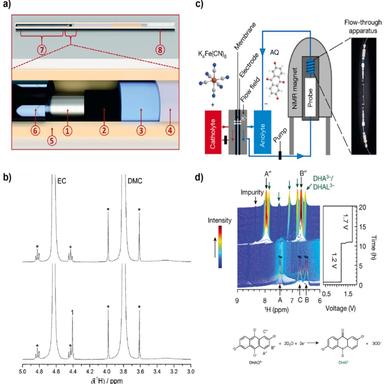
.2. (a) Schematic diagram of an in situ battery cell that fits inside a standard 5 mm outer diameter glass NMR tube showing (1) cathode current collector; (2) cathode; (3) separator; (4) Li metal coated on current collector foil; (5) polymer tube; (6) electrolyte; (7) NMR measurement area; (8) glass NMR tube. (b) 1 H NMR spectra of a LP30 electrolyte from the in situ cell before cycling (top) and after the first charging step (bottom). Signals marked with correspond to 13C satellites from EC and DMC, the p